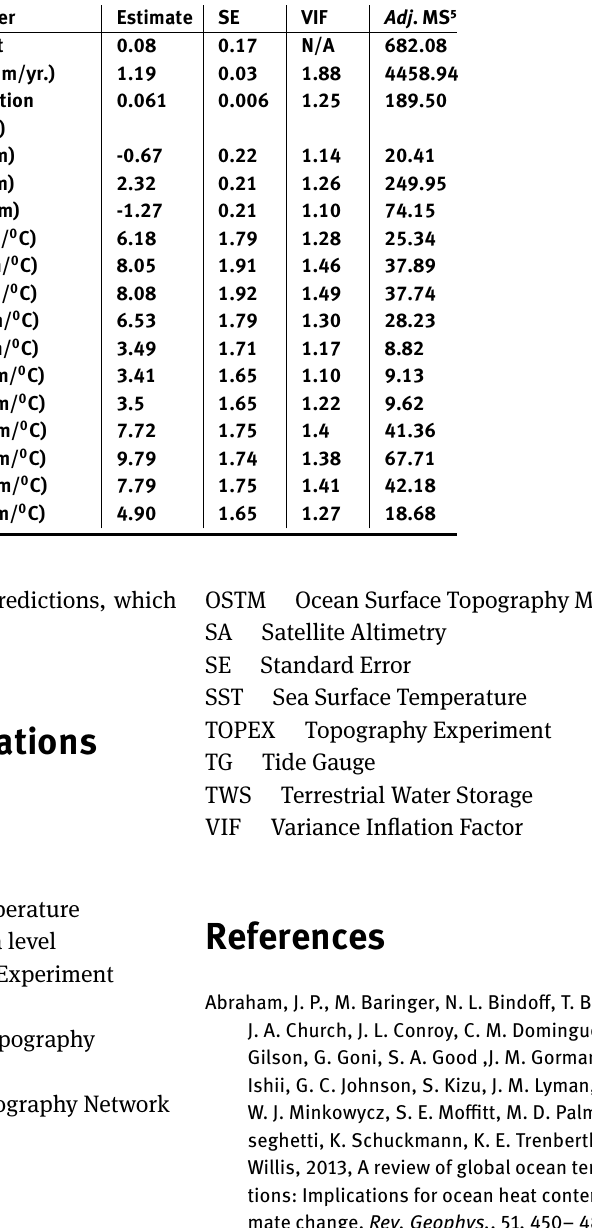
Table 3. The mixed kinematic model’s LS solution statistics. The parameters, α h , γ h are the estimated parameters for the sine and cosine components for the two periodic variables of lunisolar origin with periods P = 18.6 and 11.1 yr. Lag-weights, are denoted by β s where sub- scripts refer to the lags in years. All estimates are statistically significant ( α =